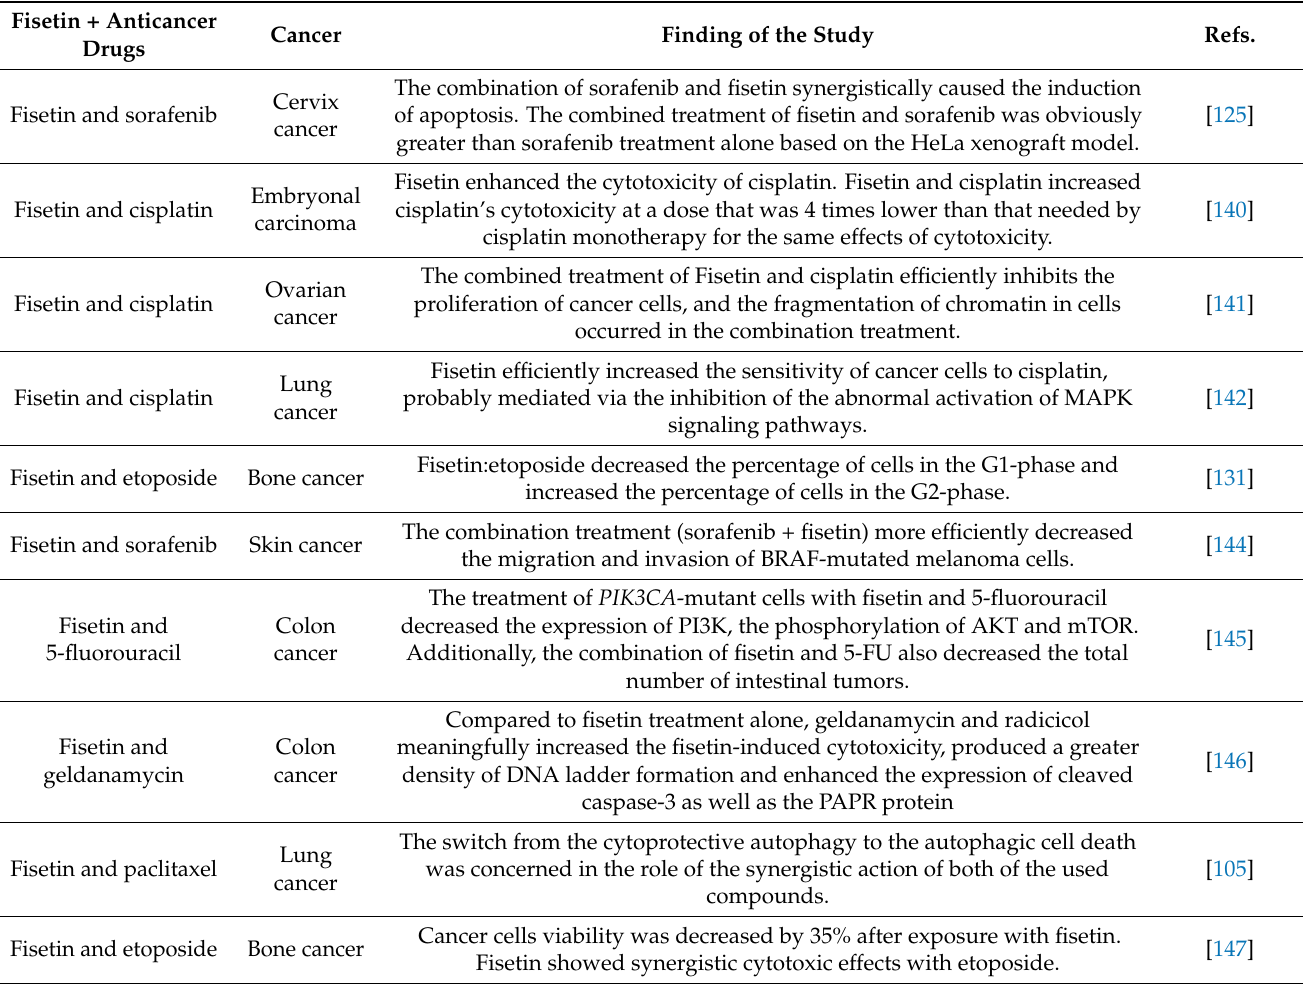
Table 3. Synergistic effects of fisetin with different anticancer drugs. Finding of the Study